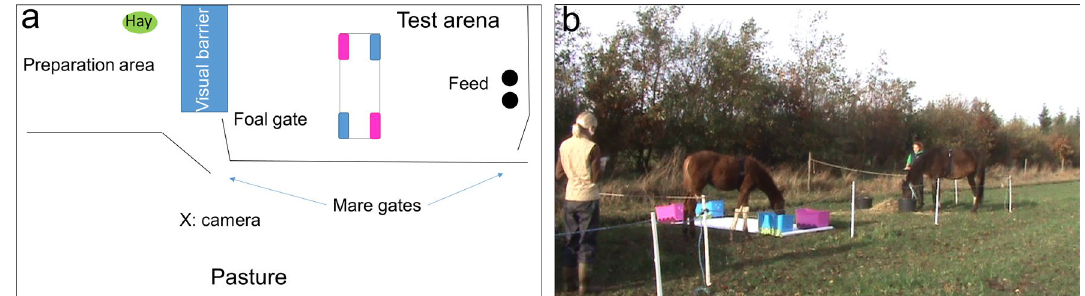
Figure 2. ( a ) Illustration of Novel Object Test (NOT1_foal) conducted with the 5 months old foals. A preparation and test arena were fenced off within the horses’ usual pasture. The foal was kept in the preparation area behind the visual barrier (2 m high) while the mare was led around the test arena and entered through the gate by the feed containers. The foal was gently pushed into the test arena and the 120 s test started when the foal placed a front leg in the arena. ( b ) Foal showing exploratory behaviour (touching and manipulating the with their mothers. The mares were only handled for insemination and occasional hoof treatment if required, and the foals were unhandled prior to the training for the experiment. During the autumn and winter, the mare-foal pairs were all housed together in a large barn with straw bedding and free access to pasture and to a roughage mixture. The foals were all weaned together in February (at 7–9 months of age) and were transported in groups by truck to a nearby facility belonging to the same stud, where they were housed in group boxes. Feeding and management was as before weaning. Novel object test at 5 months (NOT1_foal).